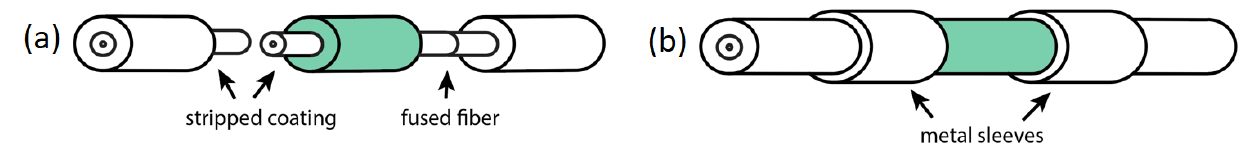
Figure 2. ( a ) For fusion splicing the coating is stripped off the ends of two types of fibers and an electric arc is used to melt the fiber’s core and cladding back together ( b ) to increase mechanical stability and protect the fused bare fibers metal sleeves are applied over the junctions.